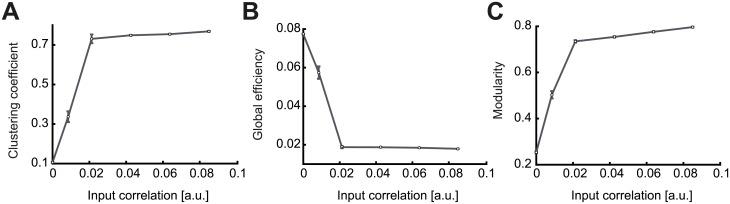
Emergence of assemblies in the presence of structured external input.A. Mean clustering coefficient versus the pairwise correlation coefficient of the input pattern. The strength of the correlation was provided as ratios (0.01, 0.05, 0.125, 0.25, 0.375 and 0.5) of the possible maximum weight of each individual synaptic connection wmax. B. Mean global efficiency versus the pairwise correlation coefficient of the input pattern. C. Mean modularity versus the pairwise correlation coefficient of the input pattern. The rapid increase of the clustering coefficient and the modularity combined with a decrease of the global efficiency is a feature of robust assembly formation. Sufficiently strong correlations in the external signal generate tight assemblies. All results are calculated from 100 trials at steady state connectivity. Error bars represent the standard error of the mean.